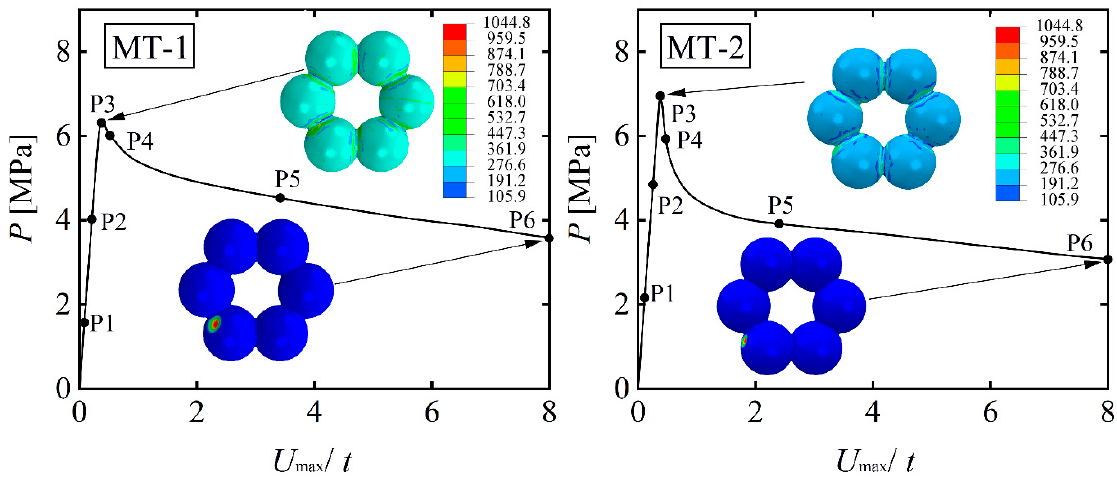
Figure 9. Equilibrium paths, stress distribution, and post-buckling modes of ST-1 and ST-2 sphere- segmented toroidal shells.